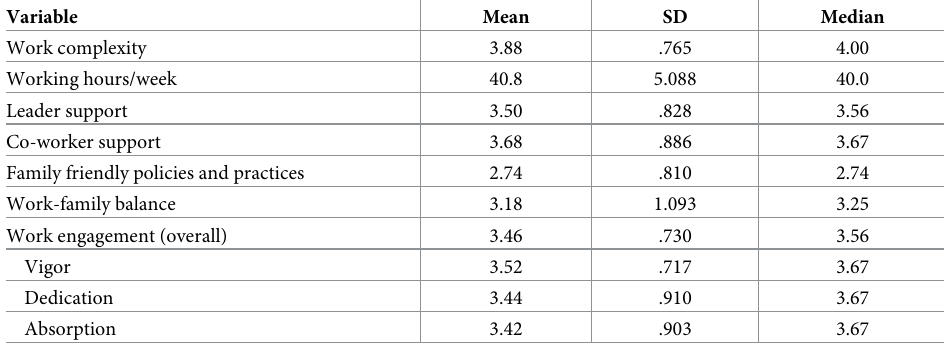
Table 1. Mean values, standard deviation and median for dependant and independant